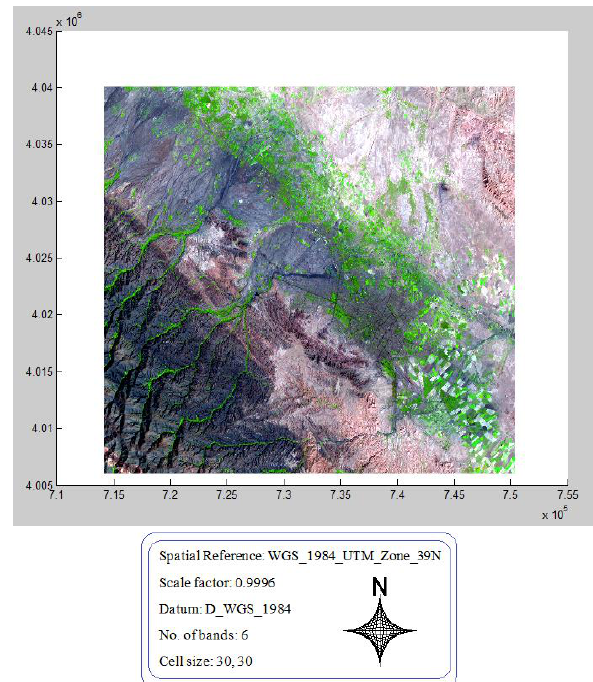
Figure 2. The first Landsat TM satellite image of the study area acquired at April 22, 1987